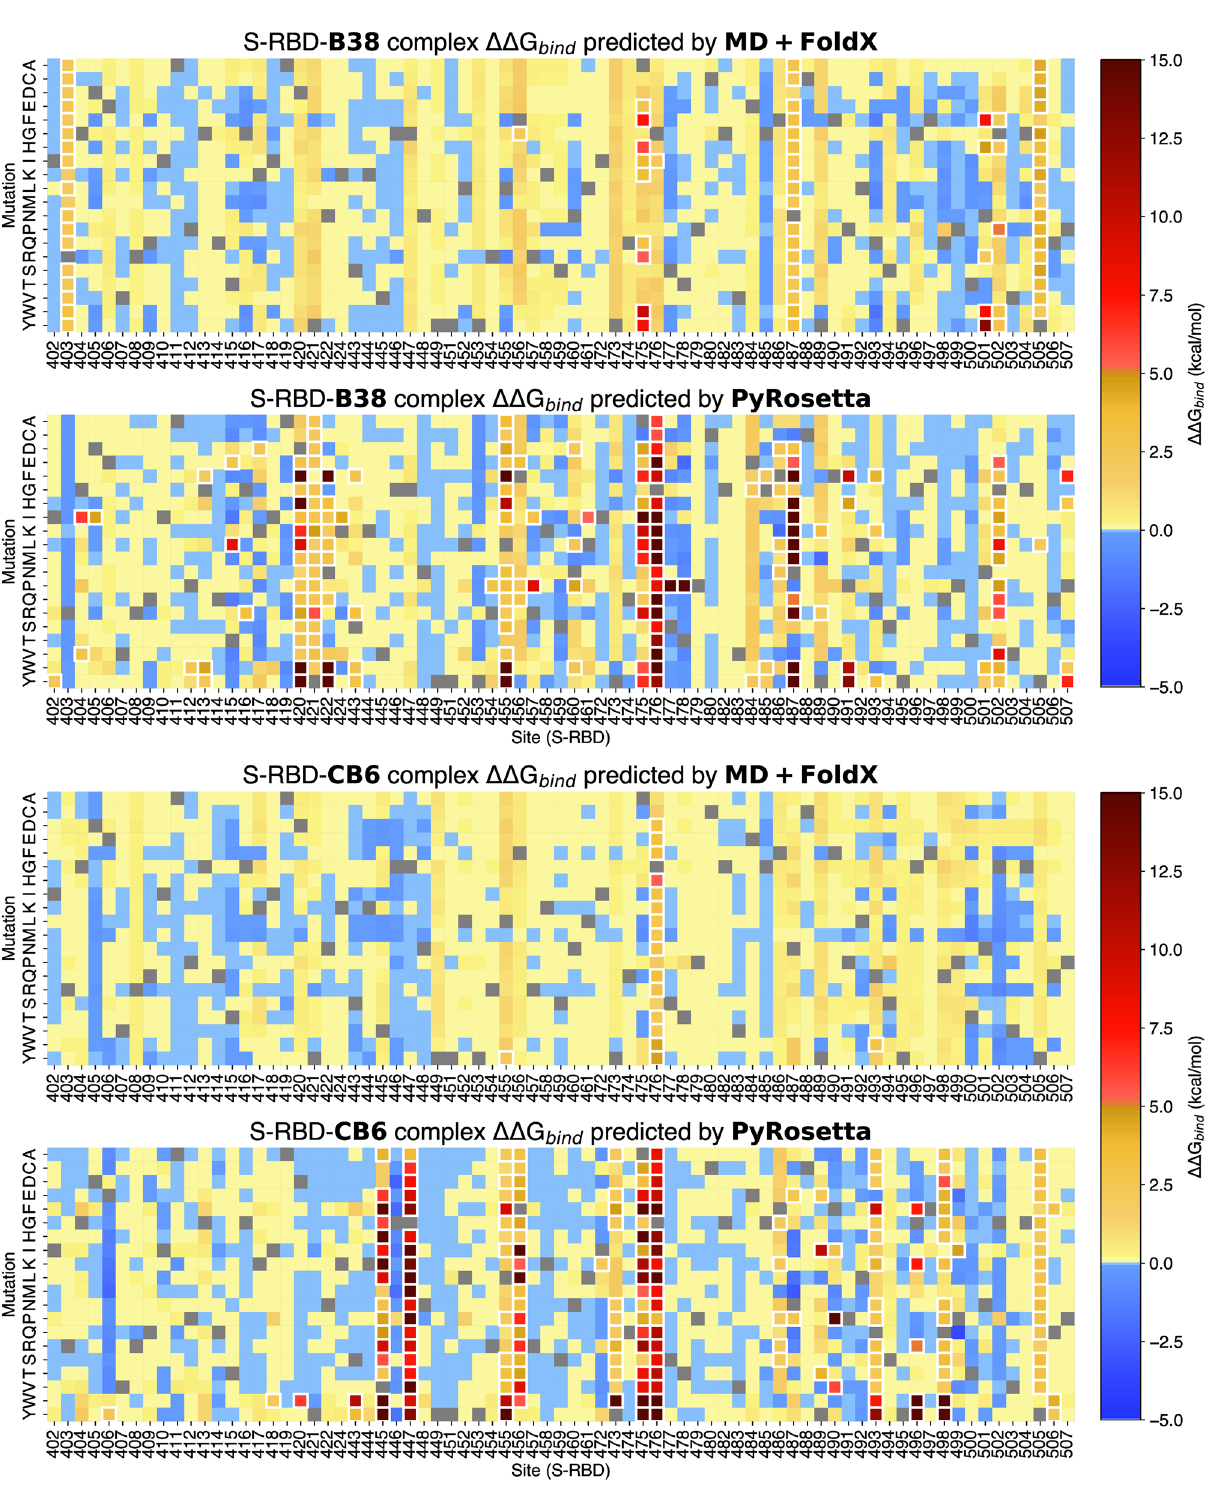
Figure 2. Heatmaps for S-RBD mutations showing PyRosetta and MD + FoldX predicted ΔΔG bind values for all possible 19 mutations at each site on the epitopes of B38 (top) and CB6 (bottom) antibodies. Blue indicates mutations that lead to stronger binding (ΔΔG bind < 0), yellow and red indicates binding disruption (ΔΔG bind > 0). The white highlighted data points are cases where the ΔΔG bind values are above the cutoff, hence are predicted to be antibody escape mutations (ΔΔG bind > 2 kcal/mol). This figure was generated using the Python programming language v3.10.8 (Python software foundation, https:// python. org) and the matplotlib plotting module v3.5.2 40